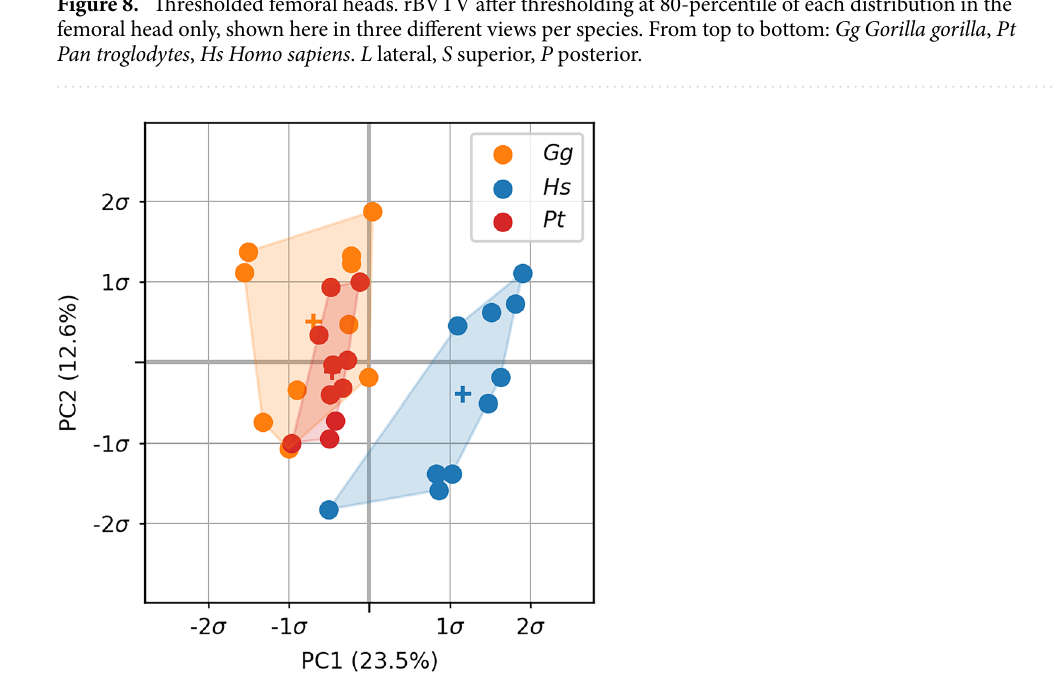
Figure 9. PCA plot for the femoral head. The plot shows the first two components in the principal component space for rBVTV. Gg Gorilla gorilla , Hs Homo sapiens , Pt Pan troglodytes